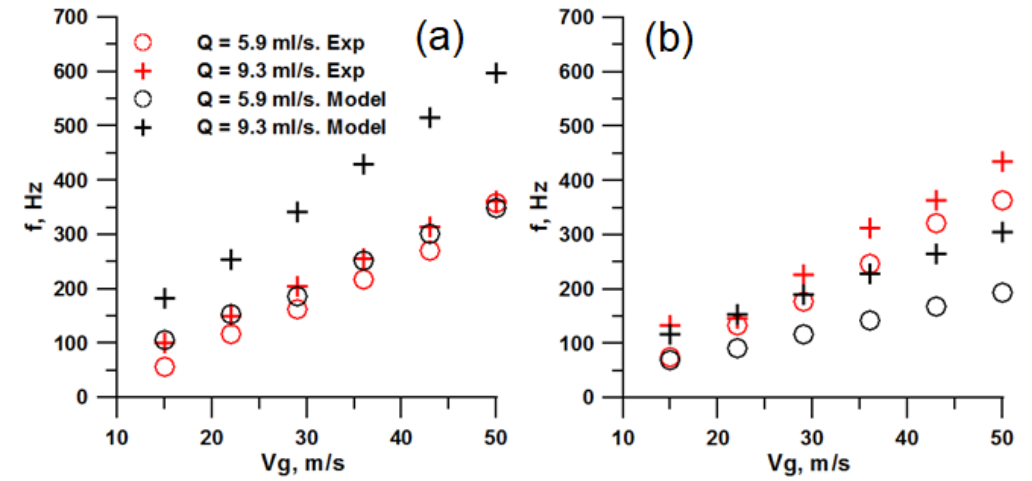
Figure 9. Comparison of the measured against the calculated wave frequency: ( a ) water; and ( b ) WGS2.